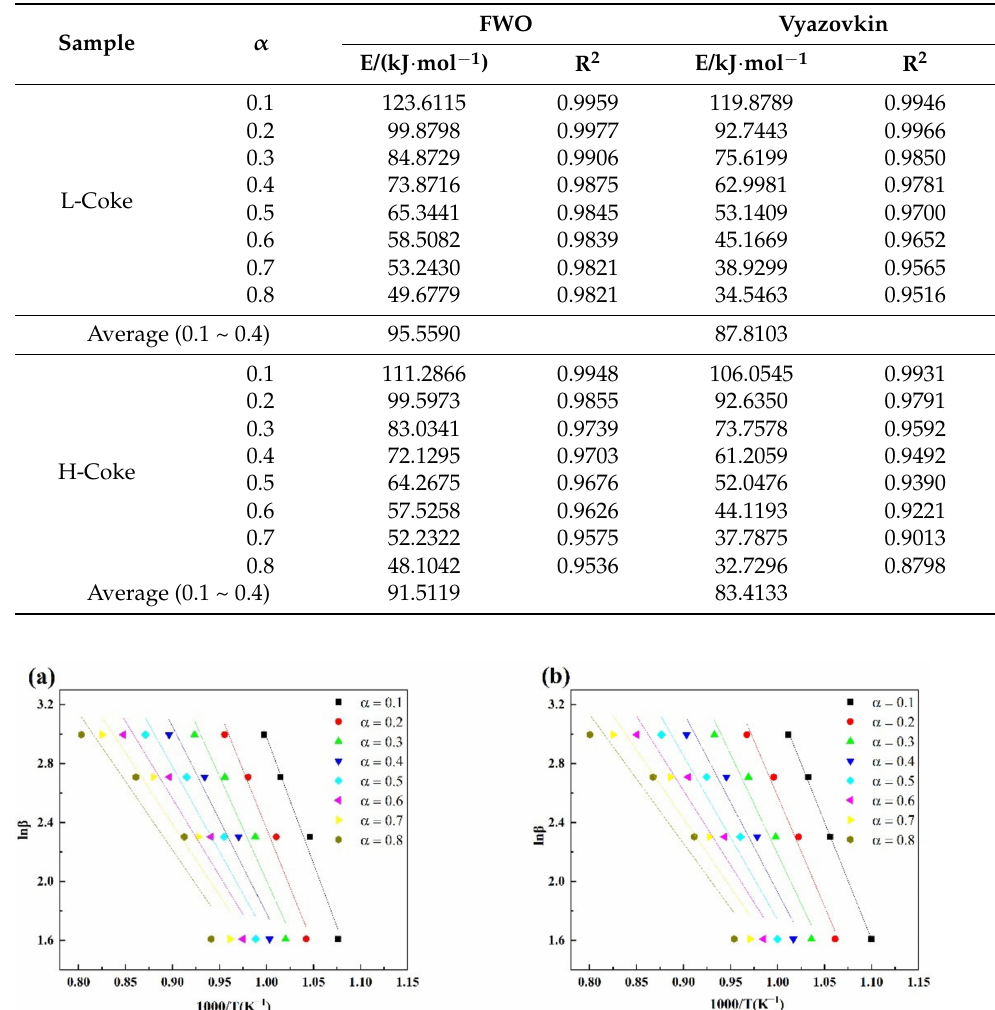
Table 5. Kinetic parameters of coke based on the FWO and Vyazovkin methods.